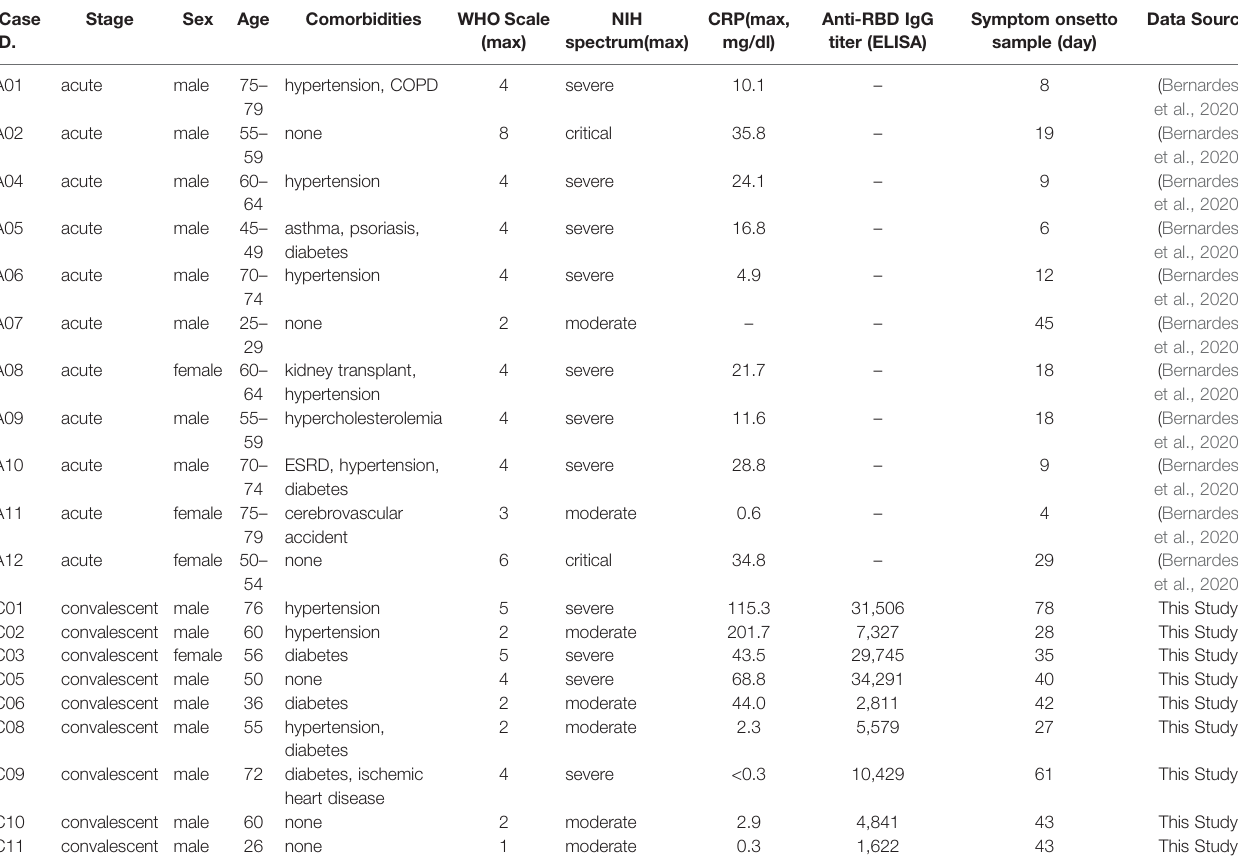
TABLE 1 | Clinical features of the coronavirus disease 2019 (COVID-19) patients. Case